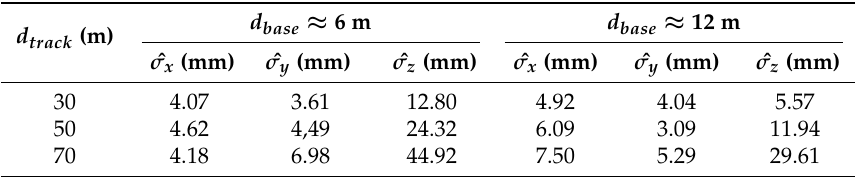
Table 3. Standard deviations ˆ σ ( C ) at different tracking distances d track